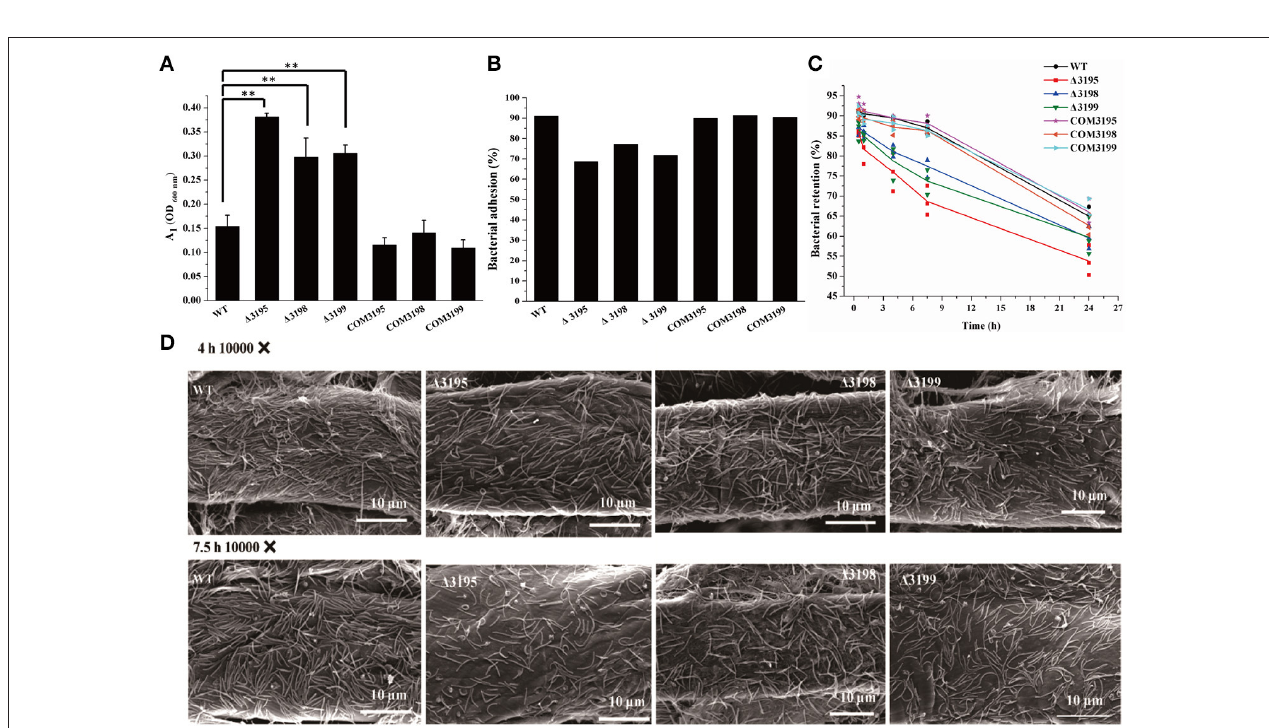
FIGURE 8 | Analyses of WT and t2s mutant cell adhesion to cellulose. (A) The cell density (A 1 , OD 600 nm ) of the resultant supernatant after bacterial adhesion to cellulose at room temperature for 40 min with gentle rotation. The cell density at 600 nm (A 0 ) before adhesion was adjusted to 1.0 for all the strains. Statistical analysis was performed using the student’s t -test analysis. Significant differences ( T- test ** P < 0.01) were detected between WT and t2s mutant strains. (B) The percentage of cells adhered to Avicel cellulose after gentle rotation at room temperature for 40 min as indicated in (A). (C) The percentage of WT and mutant cells retained on cellulose after incubation for the indicated time periods. The respective percentage of the pre-adhered WT and t2s mutant cells as described in panel B was set to 100%. Three independent results for each strain were shown. The equations used for calculation of the cell percentage were described in Section Materials and Methods. (D) Scanning electron microscopic analyses of WT and mutant cells adhered to filter paper after incubation for the indicated time periods. Panels from left to right: WT, 1 3195, 1 3198, and 1